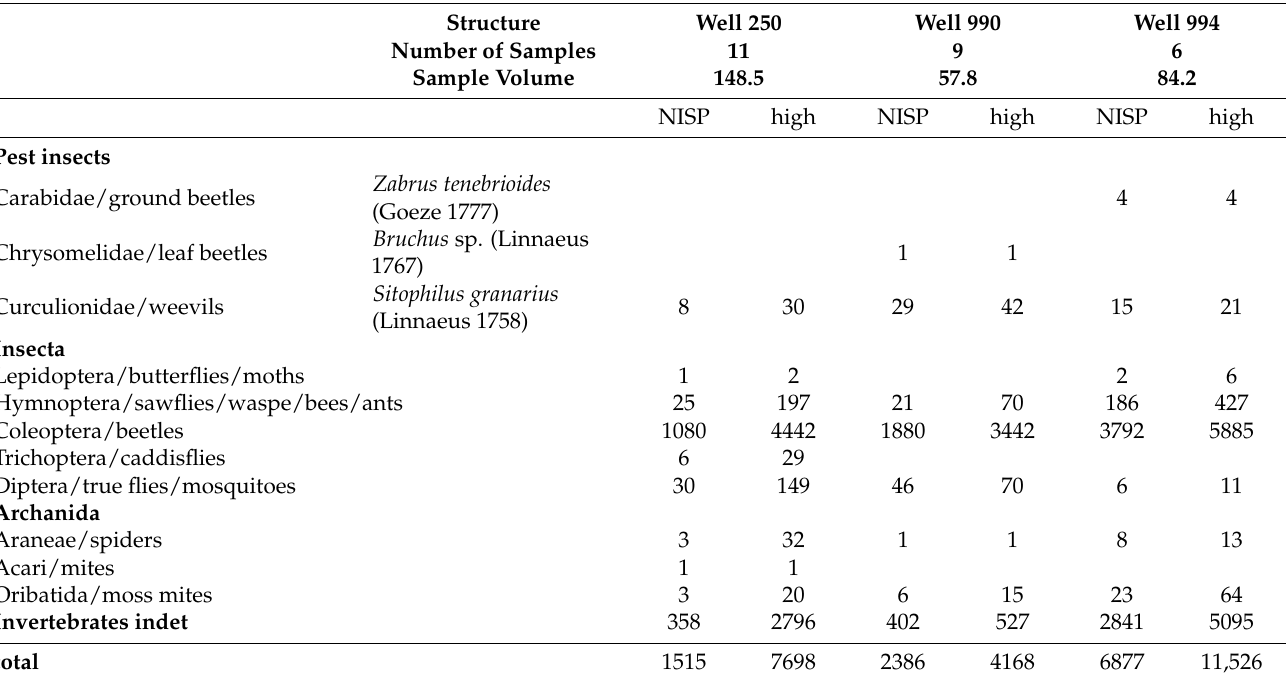
Table 3. Invertebrate pest species and invertebrate groups from wells 250, 990, and 994. Number of identified specimens (NISP) and extrapolated NISP (high) depending on the sample